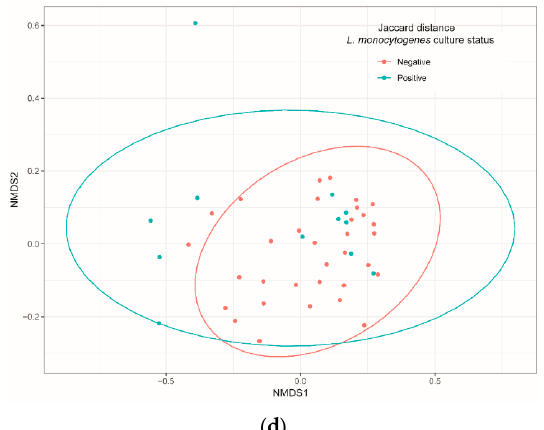
Figure 2. Non-metric multidimensional scaling (NMDS) of Bray–Curtis and Jaccard distances of bacteria communities identified using 16S Miseq sequencing technology on samples isolated from cutting facility conveyor surfaces according to sampling visit ( a , b ) and Listeria monocytogenes culture status ( c , d ). Pairwise PERMANOVA with 999 permutations (using pseudo-F ratios) was used for all comparisons. Table 2. Pairwise PERMANOVA analysis based on Bray–Curtis and analysis of variance using Jac- card distance matrices with 999 permutations.